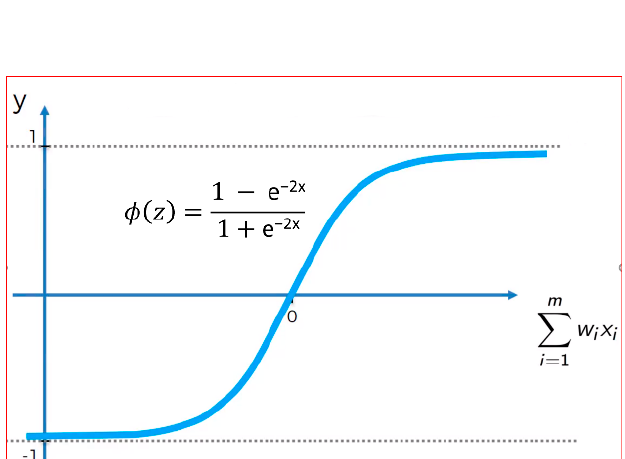
Figure 3. Tanh function. Source: https://medium.com/datadriveninvestor/neural-networks- activation-functions-e371202b56ff (accessed on 15 October 2019).